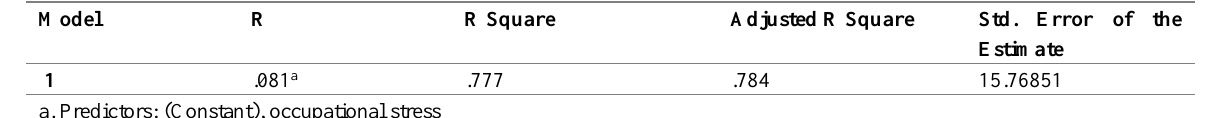
Table 6: Model Summary of Regression Analysis between Occupational Stress and